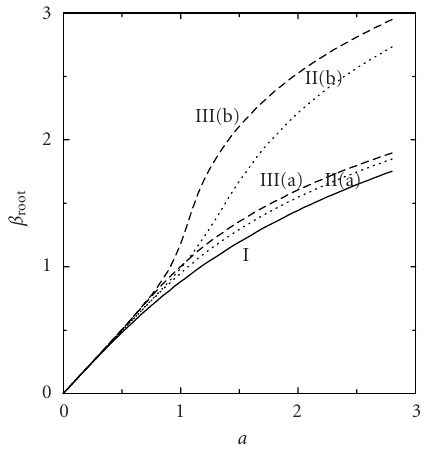
Figure 4.6. The variation of β root as a function of the parameter a for two positive values of ν . The exact solution for λ = 1. For the curve I, ν = 0 . 0. For curves II(a) and II(b), ν = 0 . 40, but x 0 = 0 . 5 and 0 . 0, respectively. For curves III(a) and III(b), ν = 1 . 0, but x 0 = 0 . 5 and 0 . 0, respectively.